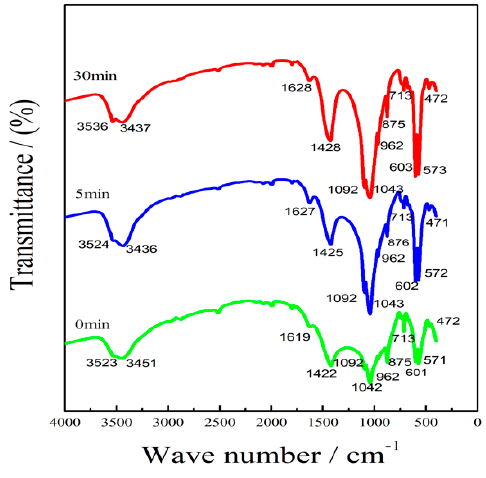
Figure 4. IR spectra of PR2 at different milling times.